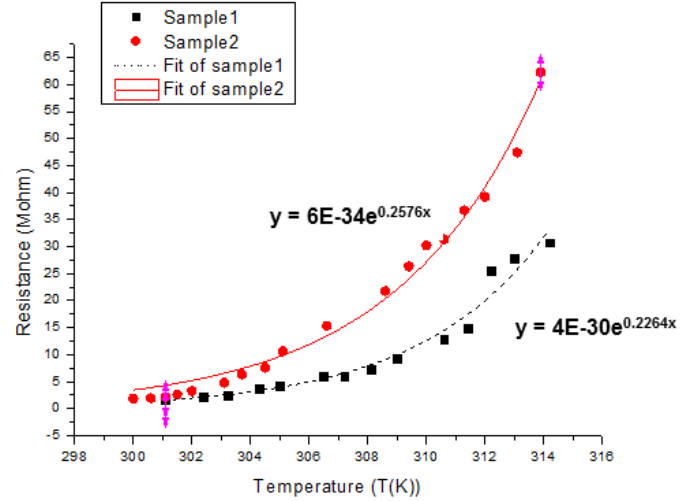
Figure 10. Cytochrome c thin film resistance versus temperature after a 10 min UV/ozone process time on an SU-8 photoresist platform